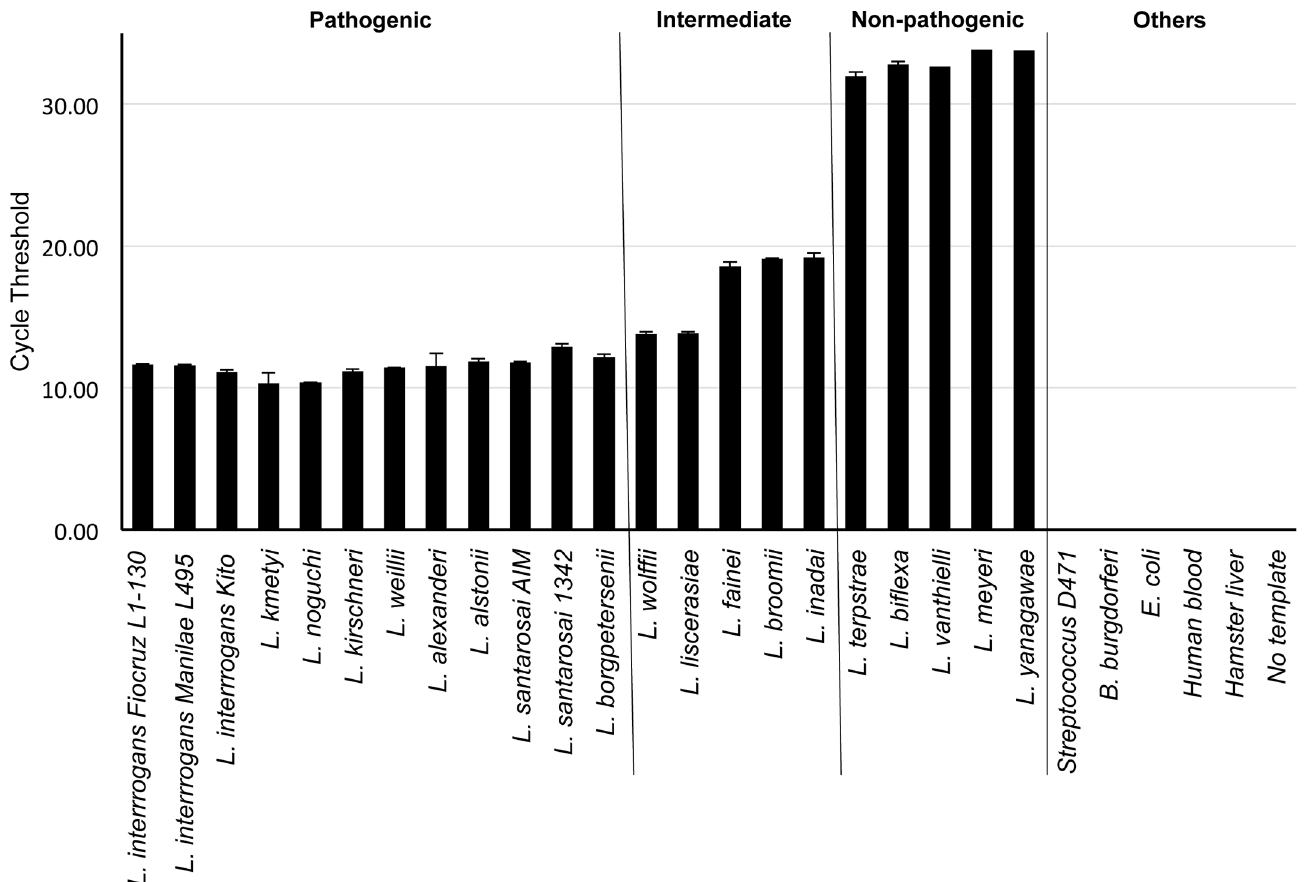
Fig 3. High sensitivity and specificity of 16S rRNA qPCR assay for pathogenic and nonpathogenic leptospiral species and serovars. Total RNA was extracted from 17 high or intermediate pathogenic, and five non-pathogenic leptospiral species, Borrelia burgdorferi , group A Streptococcus , and Escherichia coli , as well as from uninfected human blood or hamster liver, as described in the materials and methods and converted into cDNA. Equal amount (10 ng) of cDNA templates from each bacterial species were subjected to qRT-PCR assays using 16S-1 primers and amplification cycles (Ct values) were measured. Note that the sensitivity of detection is the best for all tested highly pathogenic species or serovars followed by intermediate species while non-pathogenic strains display the lowest sensitivity (an average of 15 Ct values or 10,000 fold less detectability). All tested non-target bacterial species or mammalian samples remained undetectable. Data represent results from three independent